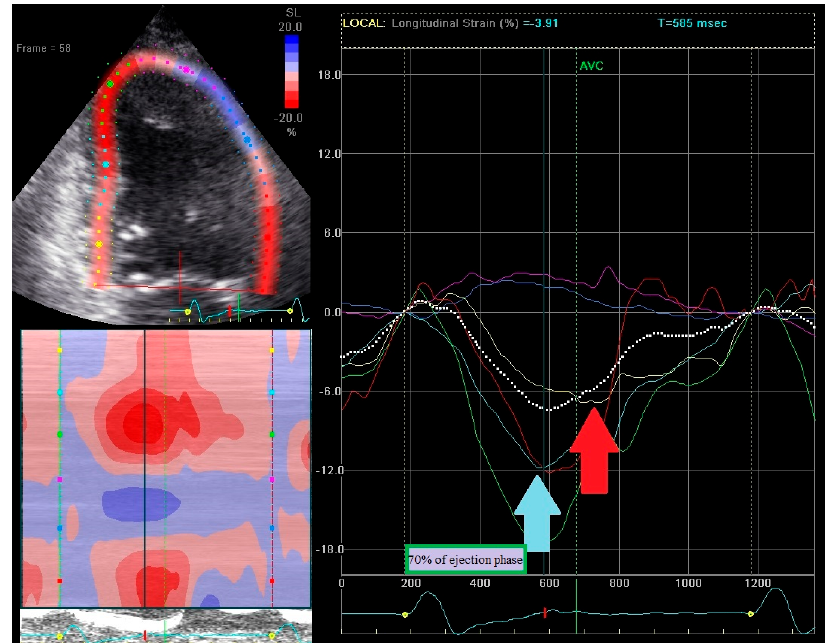
Figure 3. RSPI calculation: 2-chamber view. In 2-chamber view patient reached 2 point: the basal segment in the anterior wall exhibits contraction movement (red line; light blue arrow) [1 point], but it does not fulfill criterion of early 70% of the ejection phase [0 point]. The basal segment in the inferior wall (yellow line) does not show early stretching [0 point] but peak contraction occurs after aortic valve closure (red arrow) [1 point].